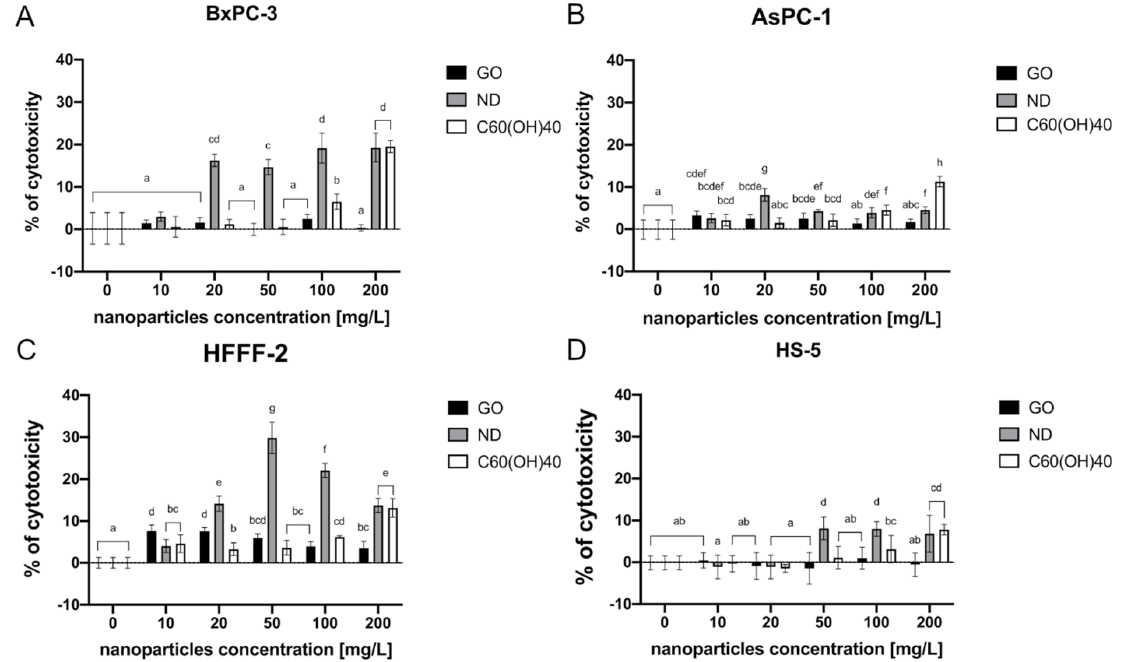
Figure 3. Membrane integrity of the cells after a 24-h incubation period with carbon-based nanomaterials as determined by an LDH assay. The results are presented as the percentage of cytotoxicity (mean with standard deviation). Different letters above the columns indicate statistically significant differences between the groups ( p ≤ 0.05). Capital letters refer to different cell lines: ( A ) BxPC-3; ( B ) AsPC-1; ( C ) HFFF-2; and ( D ) HS-5.